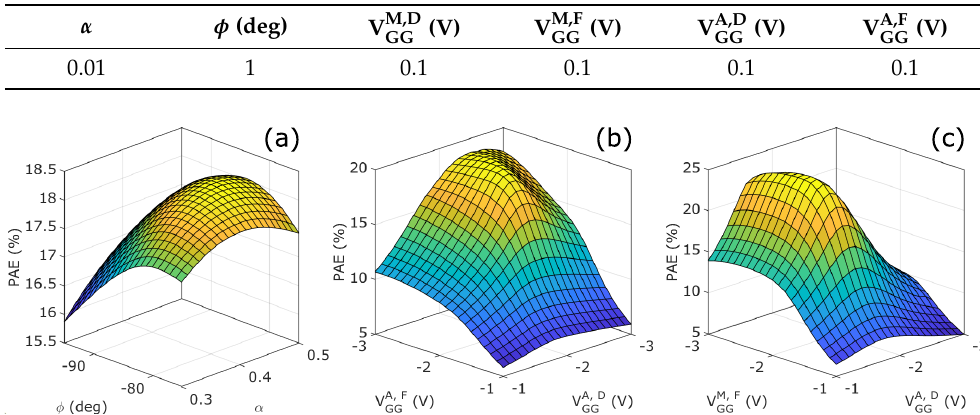
Table 2. Resolutions of the variables employed in the 2D factorial sweeps.